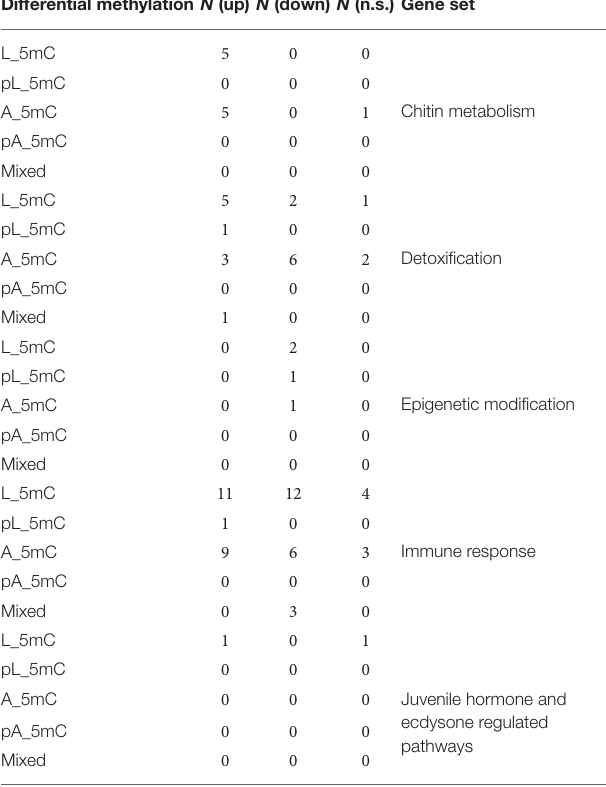
Number (N) of upregulated, downregulated (down), and not significantly differentially expressed (n.s.) genes are listed according to the type of differential methylation: higher